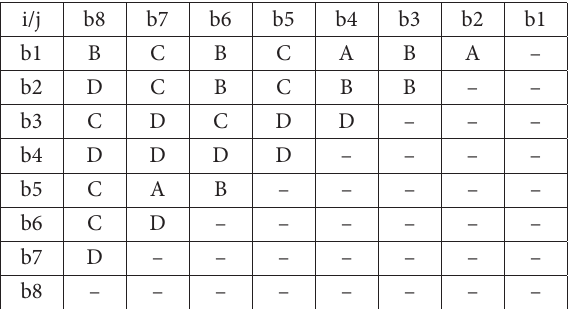
Table 1. Structural self-interaction matrix